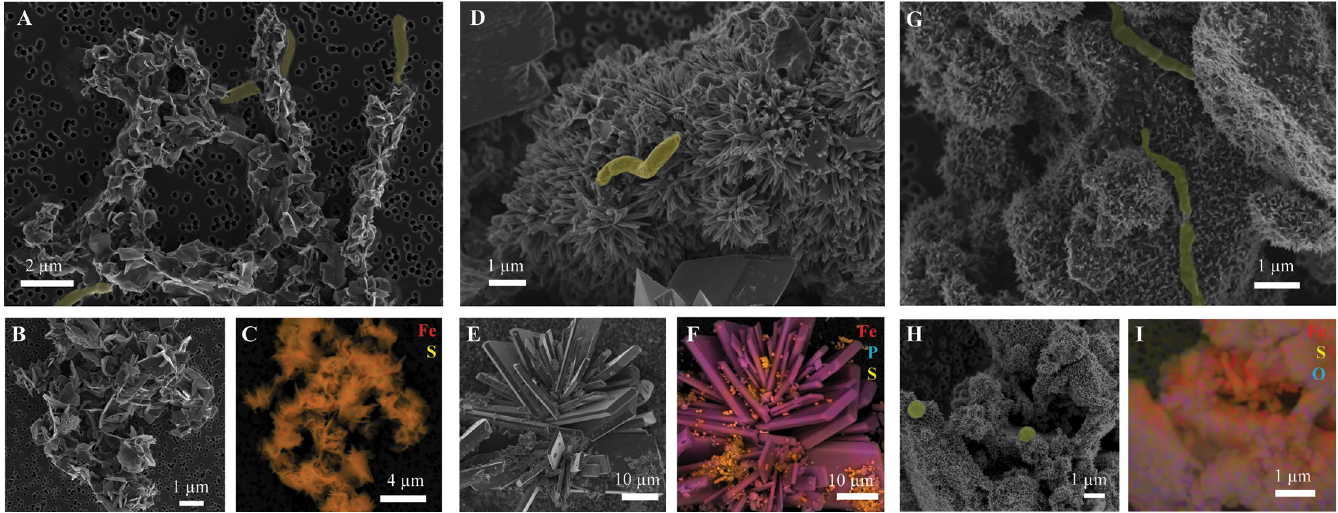
Fig 5. SEM images of morphologically diverse mineral precipitates from Lake Pavin enrichment cultures with different added iron phases. Anoxic lake water from Sept 2016 was incubated with Fe 2+ (A,B), ferrihydrite (D,E), and Fe(III)-phosphate (G,H), with added sulfate and lactate. Corresponding EDX maps (C,F,I) reveal differences in composition of precipitates from each enrichment. Microbial cells are highlighted in yellow. Analyses were performed after significant evolution of the original added iron phase was visually observed: FeLS = 18 d, FPLS = 50 d, FhLS = 75 d.